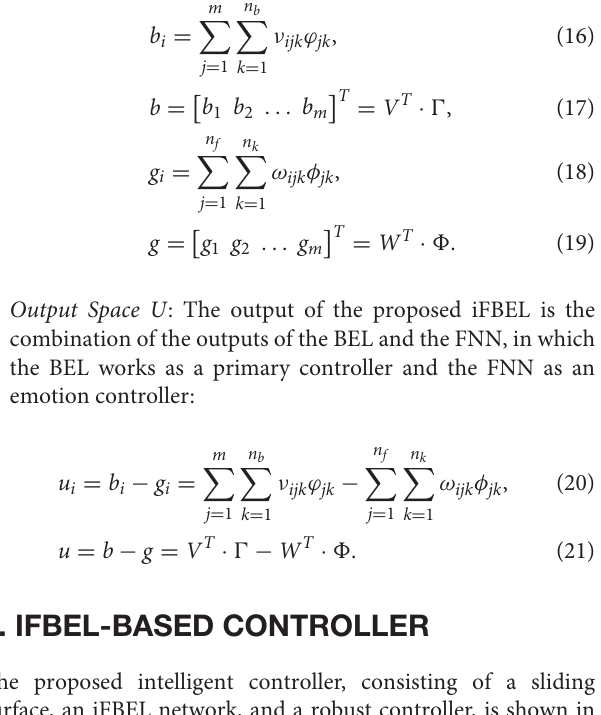
5. Sub-output Space B and G : The i th output ( b i ) and the output vector ( b ) of the BEL, and the i th output ( g i ) and the output vector ( g ) of the FNN are represented as follows: